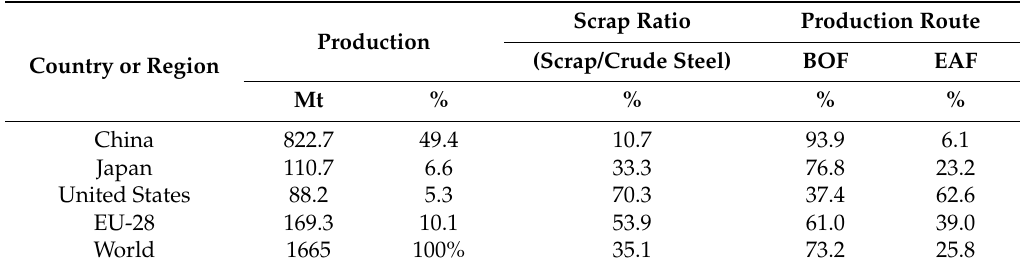
Table 1. Crude steel production by different routes in 2014.